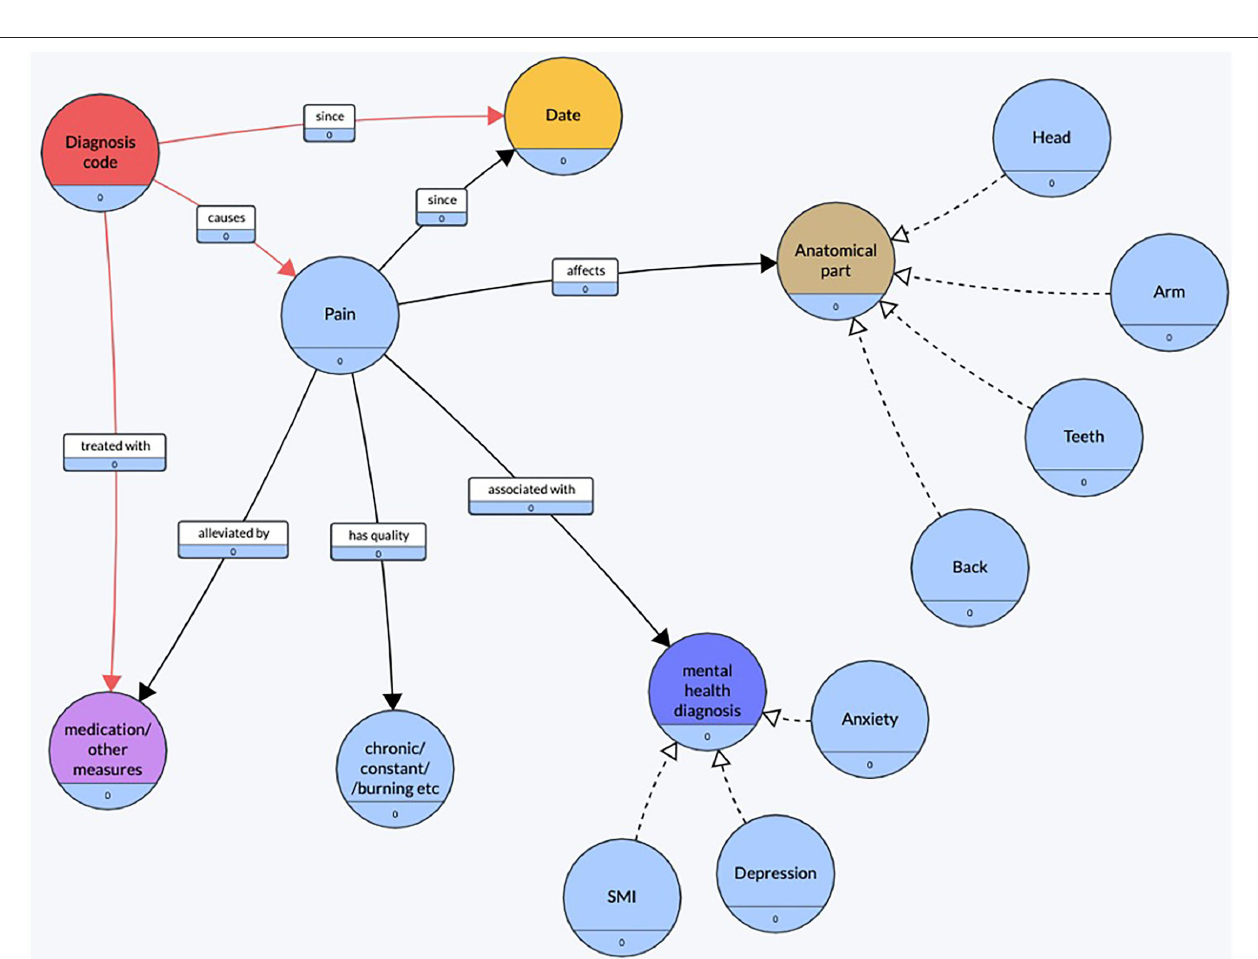
FIGURE 2 | Conceptual diagram of pain. Created using an online tool, Grafo